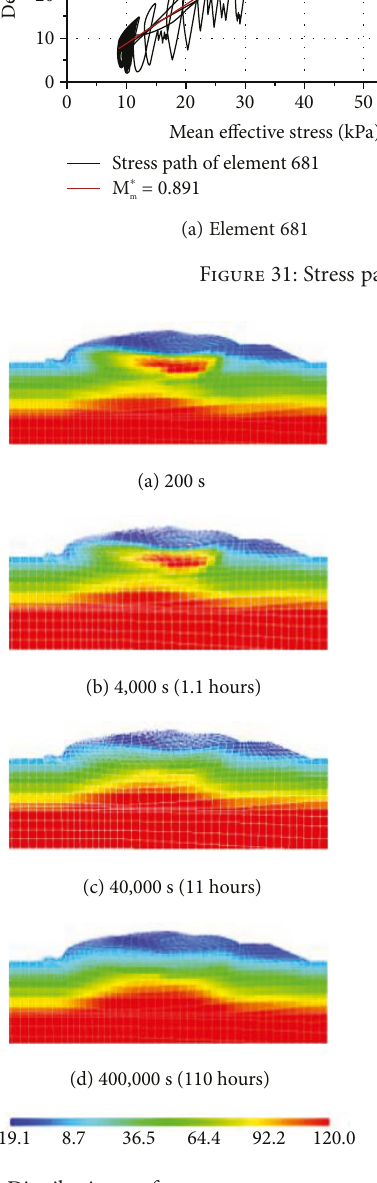
Figure 32: Distribution of pore water pressure during reconsolidation (unit: kPa).